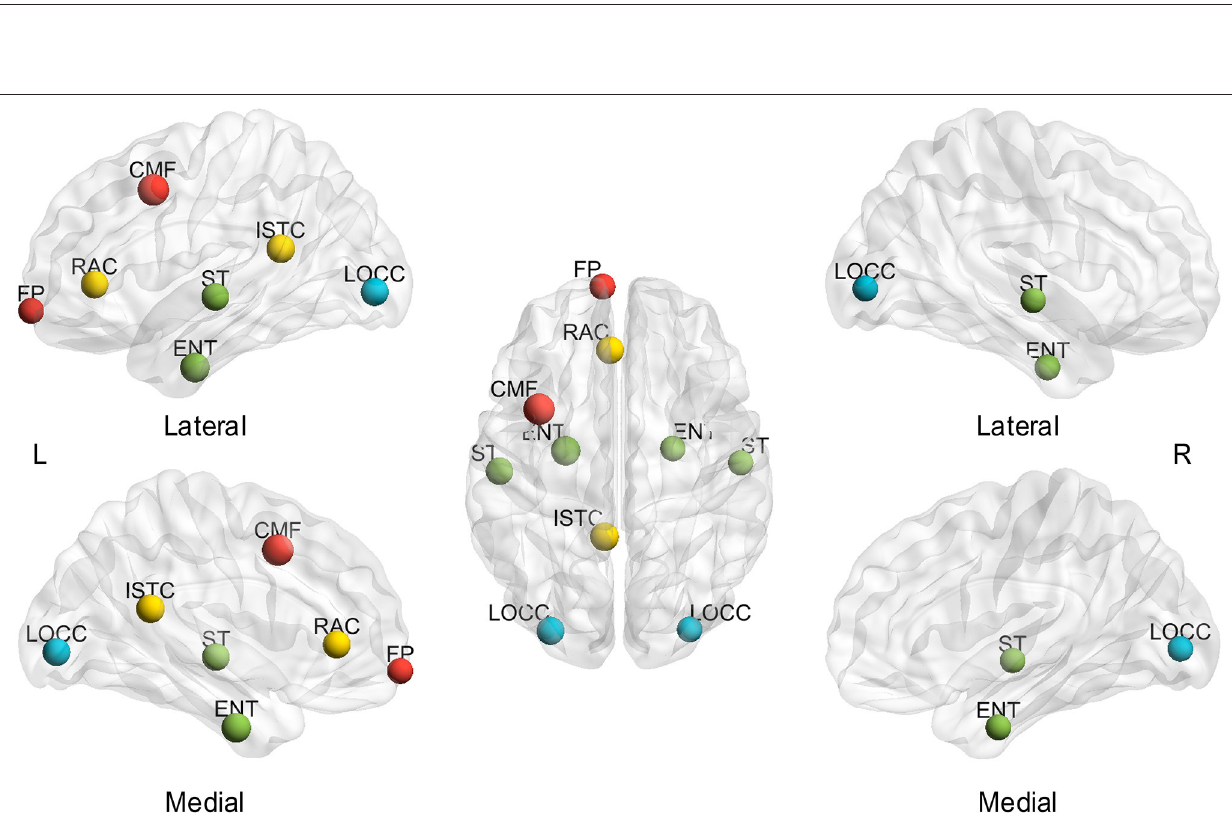
Frontiers in Neuroanatomy | www.frontiersin.org